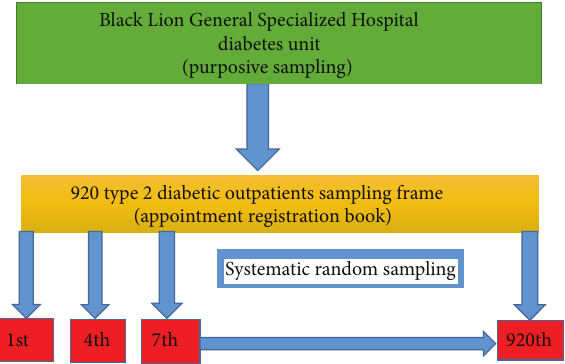
Figure 1: Schematic presentation of sampling procedure for the study in Black Lion General Specialized Hospital, Addis Ababa, Ethiopia,